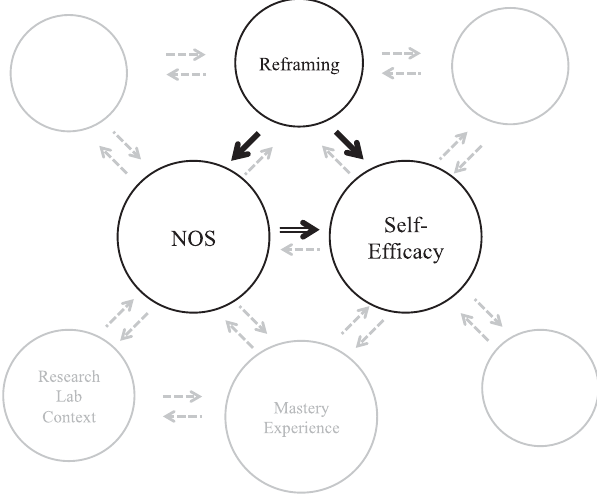
FIG. 1. Diagram representing evidence for the supporting causal connections between NOS views and self-efficacy for Frederick and Wyatt (black double lines) and inhibitory causal connections for Savannah (black solid lines). The diagram also represents connections that may be present but are not supported by data